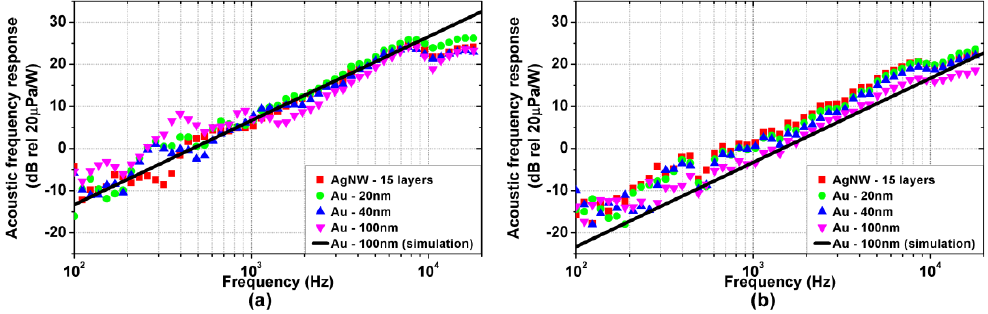
Figure 4. Experimental (colored symbols) and simulated (black solid line) thermal frequency responses (power to temperature) of the TA loudspeaker samples on ( a ) Kapton and ( b ) glass substrate.